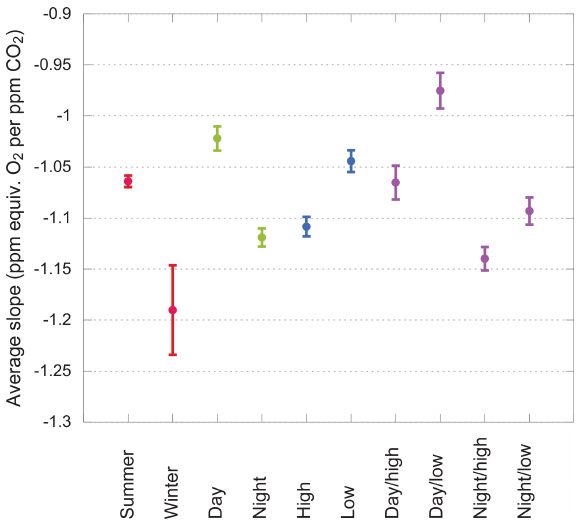
Figure 8. Average slopes for various subsets of the data. Error bars show the standard error on the mean. Subsets within each group (i.e., sharing a color) are nonoverlapping.